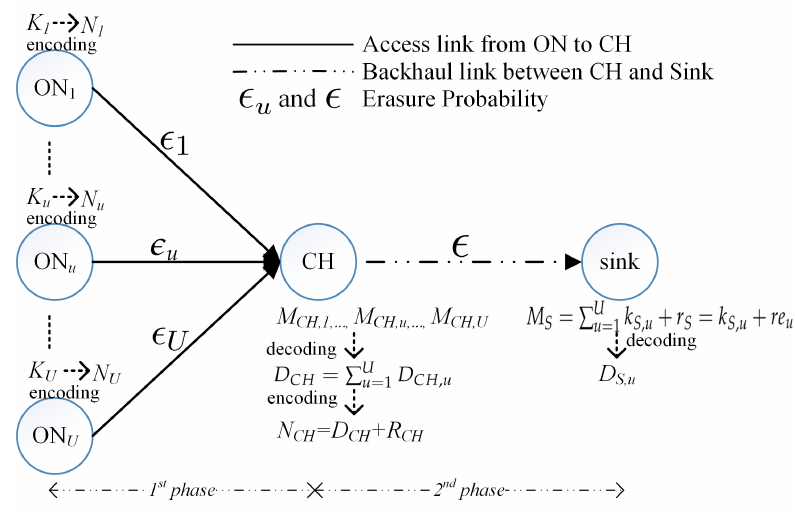
Figure 2. Encoding and decoding operations at ON, CH, and sink.